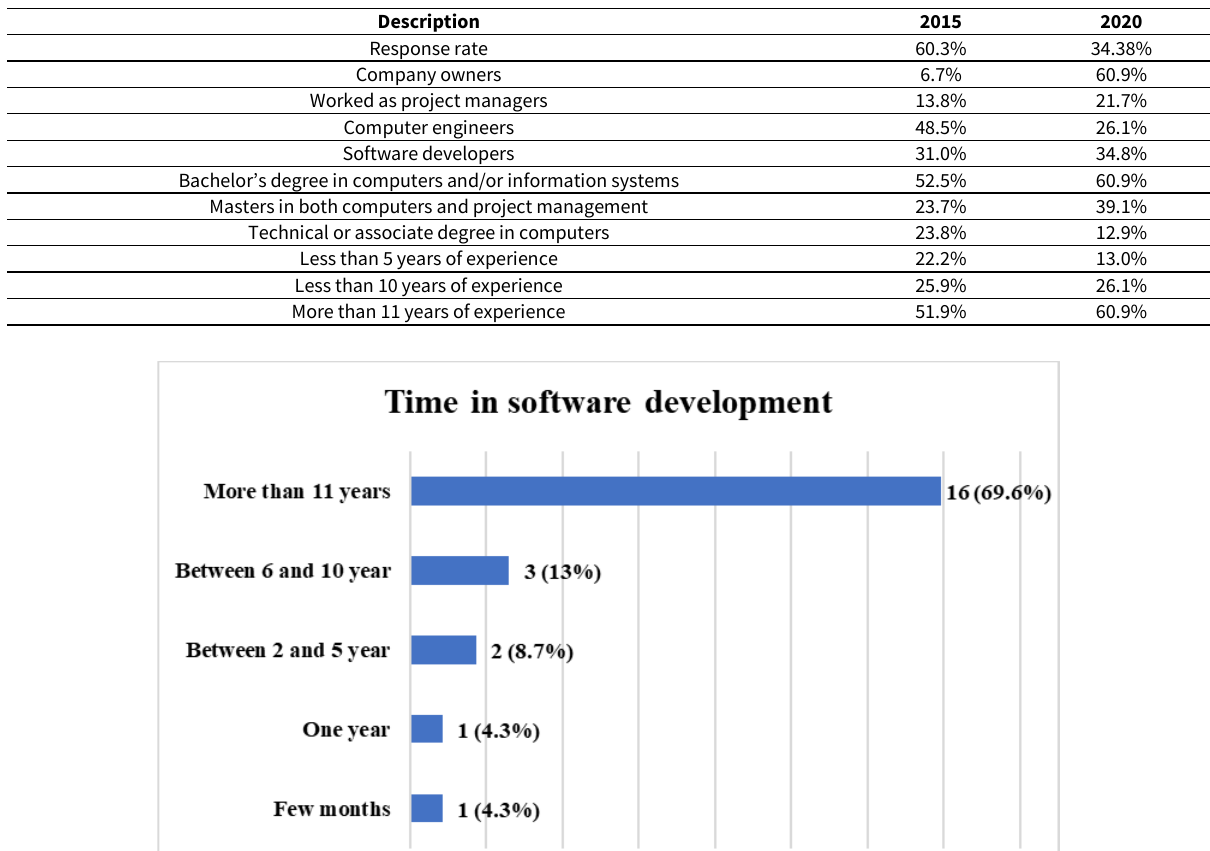
Table 2. General profile of the interviewee